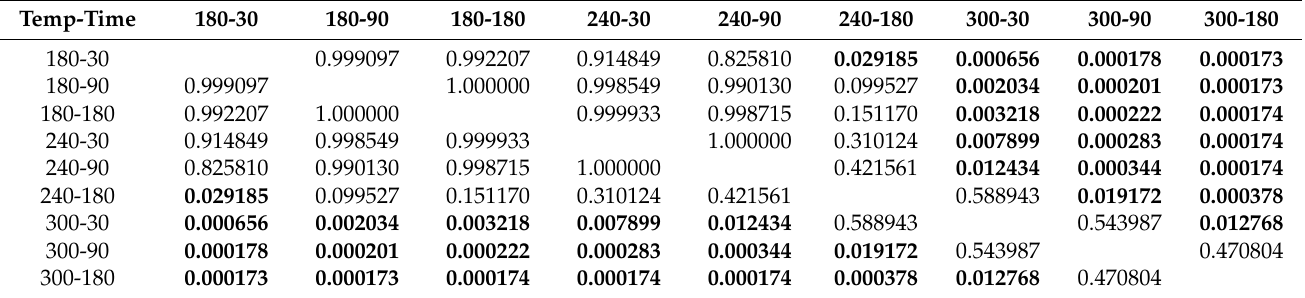
Table A8. Two-way analysis of variance (ANOVA) with post hoc Tukey test for EU , a bold font signifies a statistically significant difference ( p < 0.05).